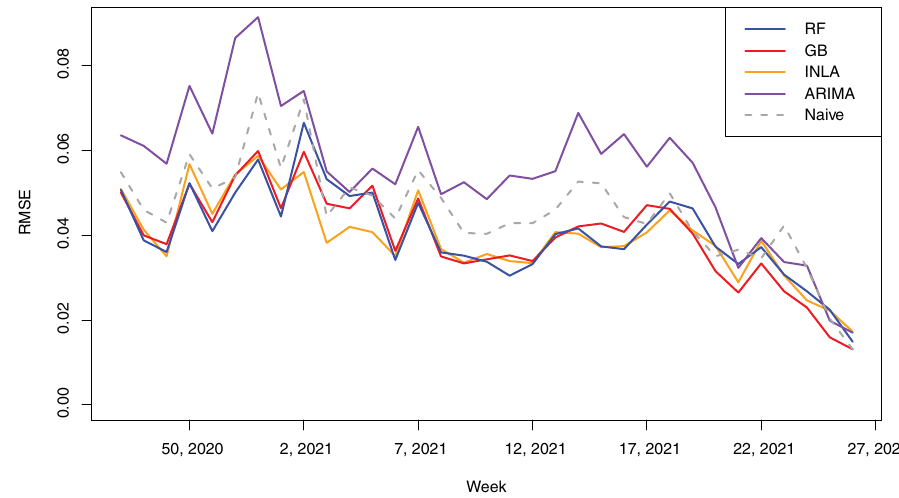
Figure 4. RMSE for the different models over time.